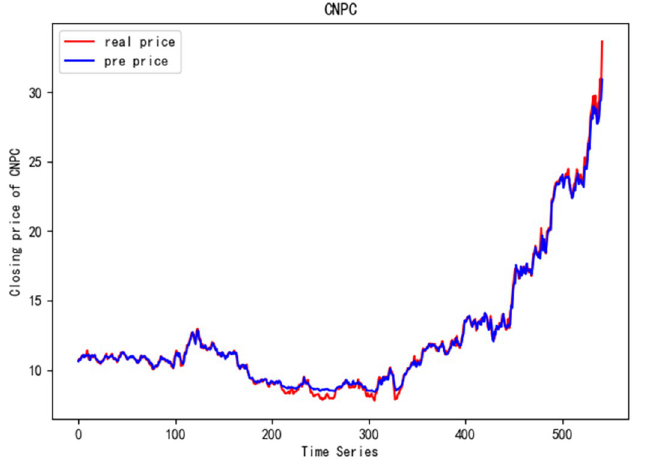
Fig 9. Closing price of CNPC.